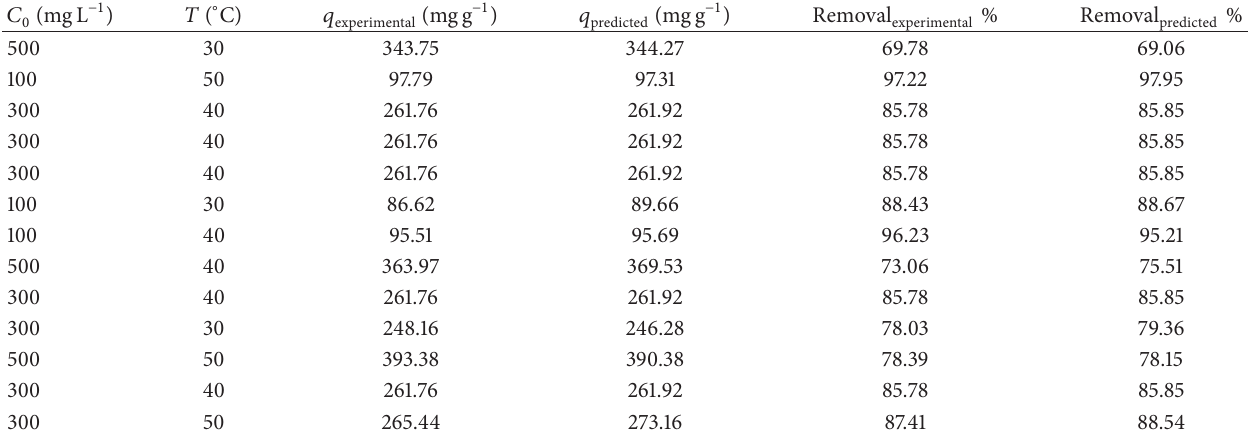
Table 6: 𝑞 and removal % values experimentally determined and predicted from